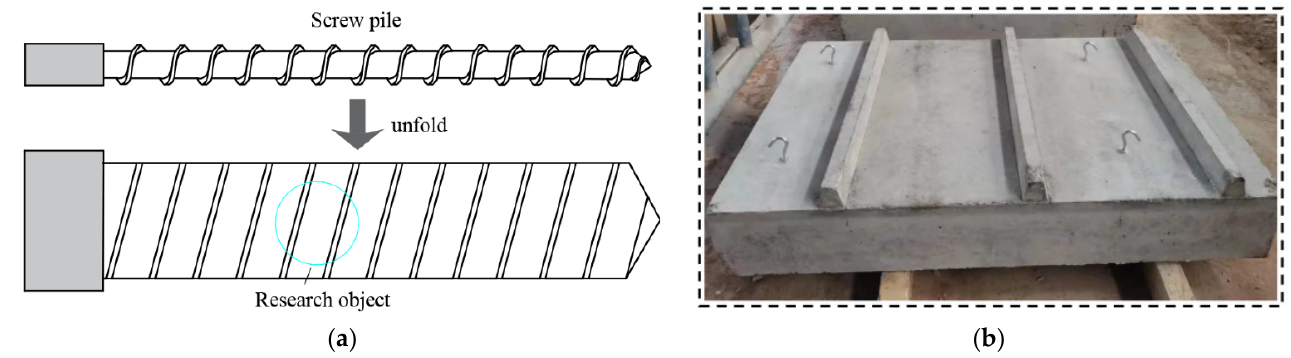
Figure 2. The object of large direct shear test. ( a ) Unfolding diagram and ( b ) screw shear plate.